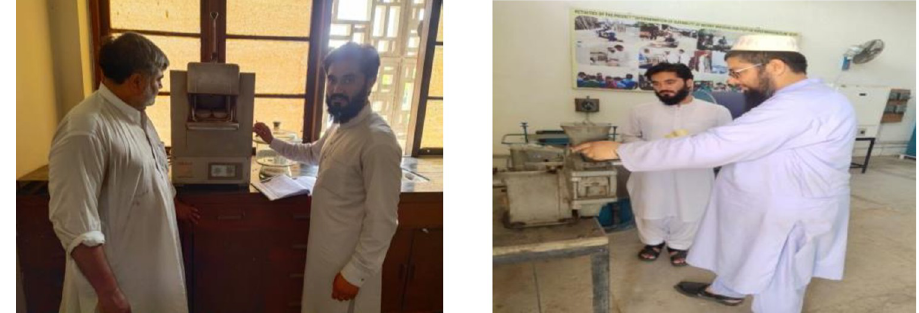
Fig 5. Calculation of ash content for biomass pellets